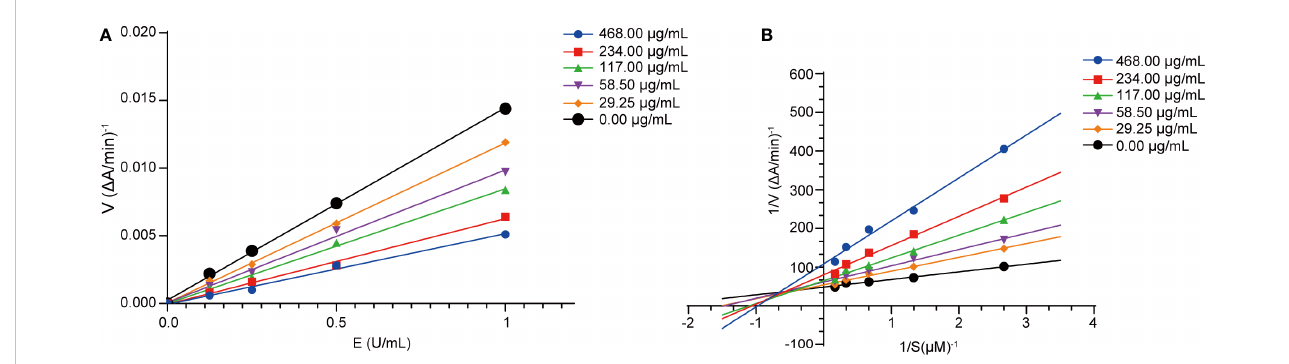
FIGURE 5 Acetylcholinesterase inhibition kinetics analysis of compound 5. (A) Hydrolytic activity of acetylcholinesterase concentration under the action of different concentrations of compound 5 (29.25, 58.50, 117.00, 234.00, and 468.00 m g/mL). (B) Lineweaver-Burk plots for the inhibition of compound 5 (29.25, 58.50, 117.00, 234.00, and 468.00 m g/mL).